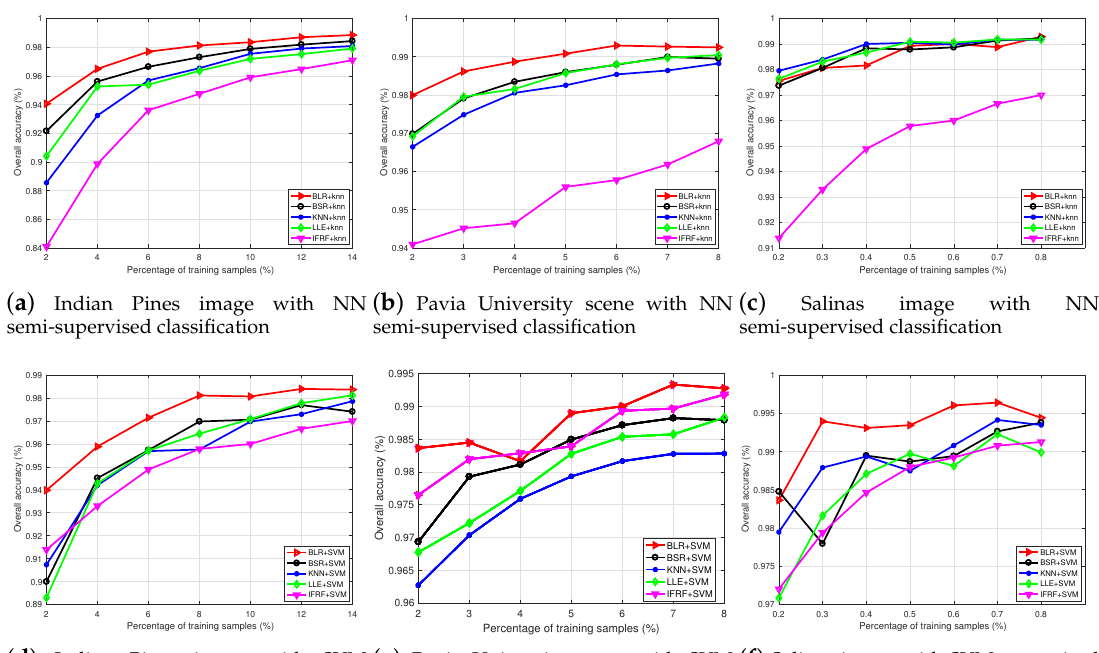
Figure 9. Supervised and semi-supervised classification accuracy of HSIs with different percentages of training samples. LLE, Locally Linear Embedding.